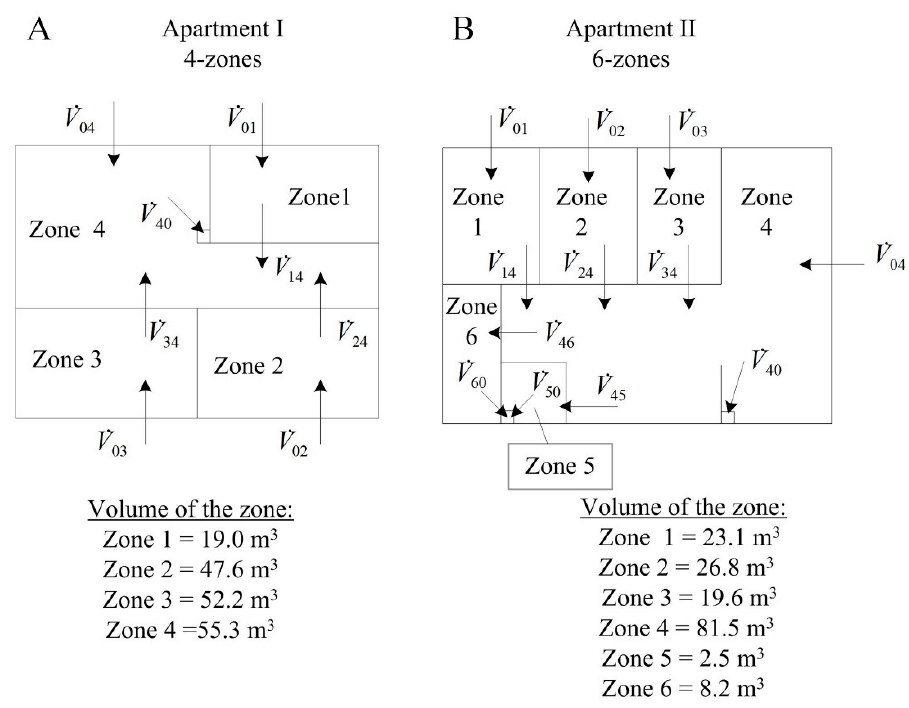
Figure 6. Model of interzonal air flow rate; A – apartment I; B – apartment II.